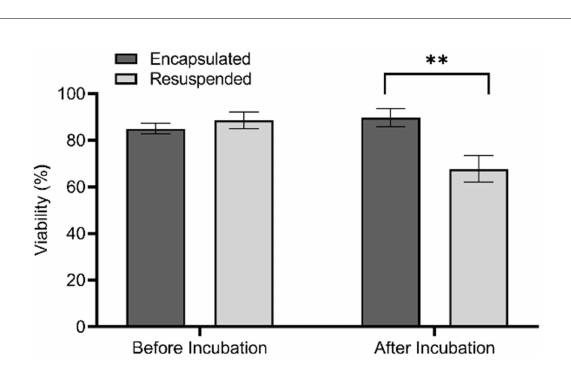
FIGURE 2 Cell viability for encapsulated and resuspended marine sediment bacteria samples before and after in situ incubation based upon a Live/Dead assay. Error bars indicate standard error, ** denotes significance of p ≤